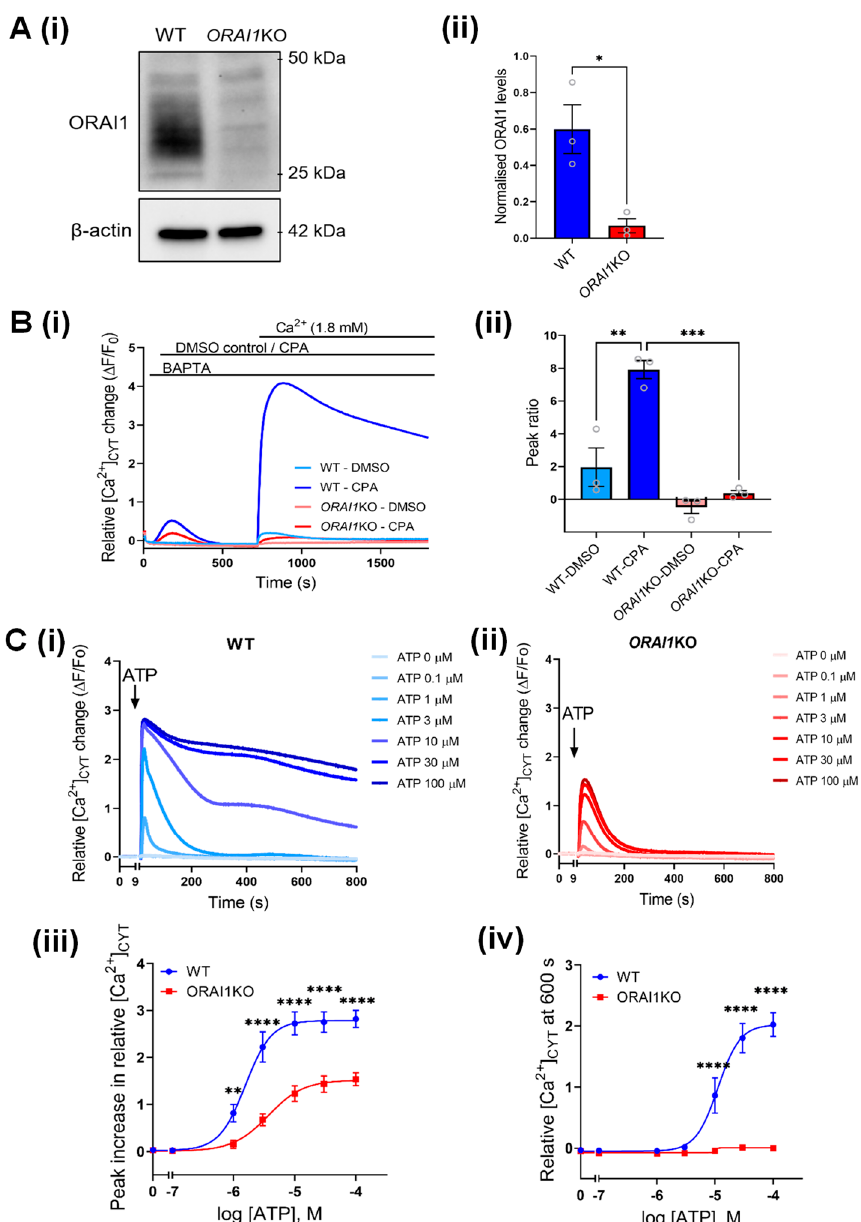
Figure 4. Characterization of ORAI1KO-GCaMP6m-MDA-MB-231 (ORAI1KO) cells. ( A ) (i) Representative immunoblot showing ORAI1 protein levels in GCaMP6m-MDA-MB-231 (WT) and ORAI1KO-GCaMP6m-MDA-MB-231 (ORAI1KO) cells. (ii) Densitometry comparing the levels of ORAI1 protein in WT and ORAI1KO cells. Statistical analysis was performed using a paired t-test. * p < 0.05 ( B ) (i) Trace shows Ca 2+ influx (CaCl 2 addition) following a 690 s pre-incubation with DMSO (unstimulated Ca 2+ influx) and CPA (SOCE) in WT and ORAI1KO cells. Bar graphs show the mean ± S.E.M of the ratio of peak 2 (Ca 2+ re-addition or SOCE) relative to peak 1 (CPA addition). Statistical analysis was performed using a one-way ANOVA with Bonferroni’s test. *** p < 0.001; ** p < 0.01 ( C ) Traces show mean [Ca 2+ ] CYT increase as a result of ATP addition in (i) WT and (ii) ORAI1KO cells. Concentration-response curves compare the (iii) peak relative increase in [Ca 2+ ] CYT and (iv) sustained increases in [Ca 2+ ] CYT at 600 s between WT and ORAI1KO cells treated with SC79. Statistical analyses were performed using a two-way ANOVA with a Bonferroni’s test. **** p < 0.0001, ** p < 0.01. Uncropped Western blots in Figure S4.